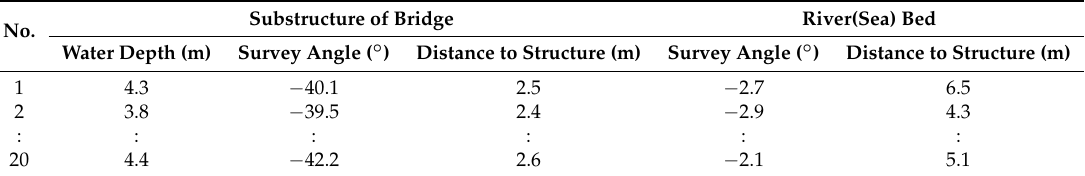
Table 2. Result of field